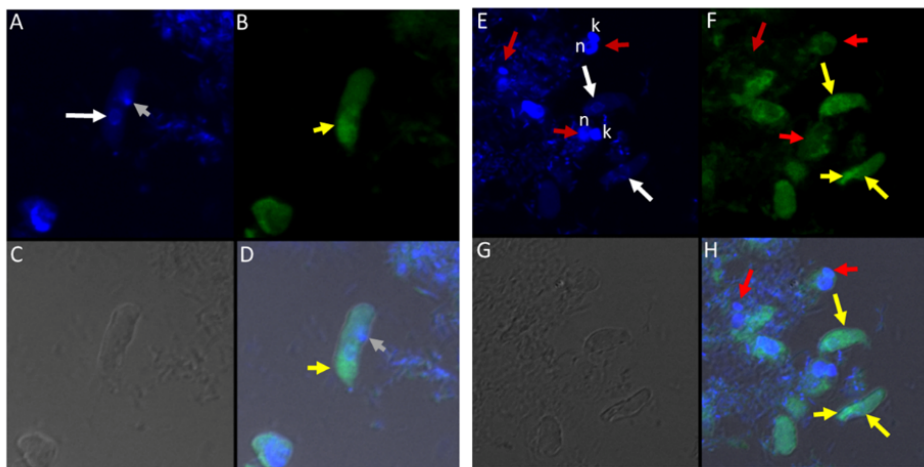
Figure 10. ( A – H ): Immunofluorescence microscopy of Colpodella sp. (ATCC 50594) trophozoites and cysts using anti- AMA-1antibodies. ( A , E ); DAPI stained nuclei of Colpodella sp. (ATCC 50594) (white arrow) and P. caudatus (red arrow) showing DAPI stained nucleus (n) and kinetoplast (k). ( B , F ) shows antibody reactivity with Colpodella sp. (ATCC 50594) trophozoites (yellow arrow) with intense antibody reactivity at the anterior end of the trophozoites (yellow arrowhead), panels ( B , D , F , H ). No antibody reactivity was observed on P. caudatus trophozoites (red arrows). ( C , G ); DIC microscopy shown the morphology of Colpodella sp. (ATCC 50594) and P. caudatus . ( D , H ); shows merged images of Antibody, DAPI and DIC. Grey arrowhead identified DAPI stained aspirated cytoplasmic contents of P. caudatus . The cross reactivity with anti-AMA1 antibody in Colpodella sp. (ATCC 50594) tropho- zoites was observed towards the apical end (Figure 10B,D,F,H, yellow arrowhead). The central nucleus of Colpodella sp. (ATCC 50594) trophozoites was identified by white arrows and the trophozoites showing strong anti-AMA1 reactivity are identified by yellow arrows. Parabodo caudatus trophozoites (red arrows) showed weak to no reactivity with the